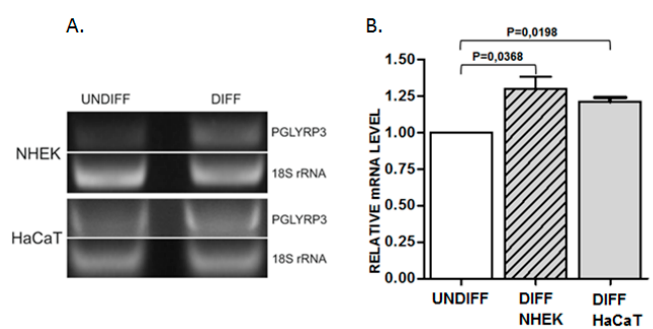
Figure 2. Analysis of PGLYRP3 mRNA level in undifferentiated (undiff) and differentiated (diff) primary keratinocytes (NHEK) and HaCaT cells. ( A ) representative PCR results. ( B ) statistical analysis of results from 3 experiments. PGLYRP3 mRNA level in undifferentiated NHEK or HaCaT cells is represented as 1.00 (white bar). The level in differentiated NHEK and HaCaT cells is represented by striped and gray bars, respectively. Data are presented as mean ± SEM.